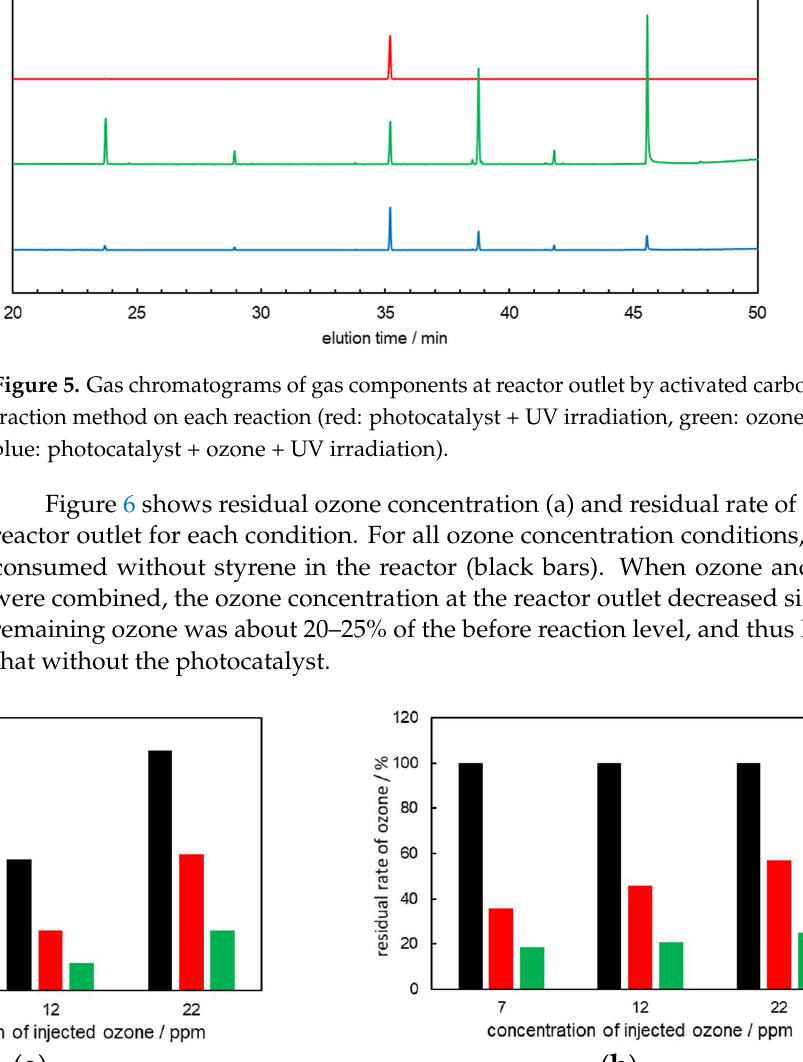
Figure 6. ( a ) Residual ozone concentration, ( b ) residual rate of ozone under each condition (black: without reaction, red: with ozone + UV irradiation, green: with photocatalyst + ozone + UV irradia- tion).